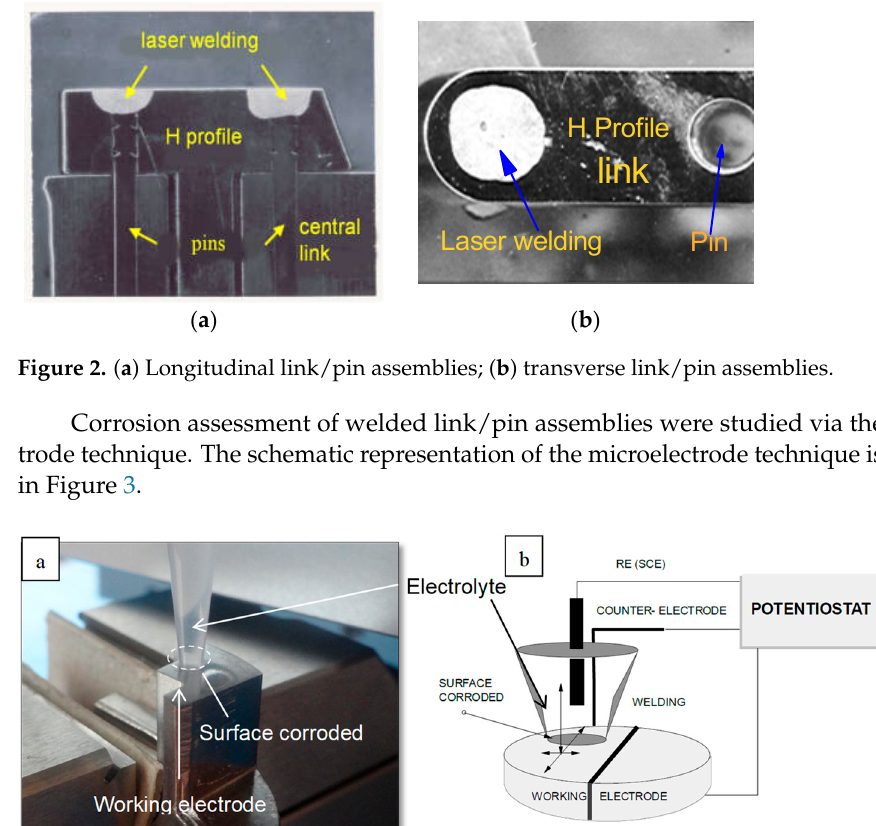
Figure 3. ( a ) Microelectrode; ( b ) the schematic representation of the microelectrode measurement system (RE: reference electrode).